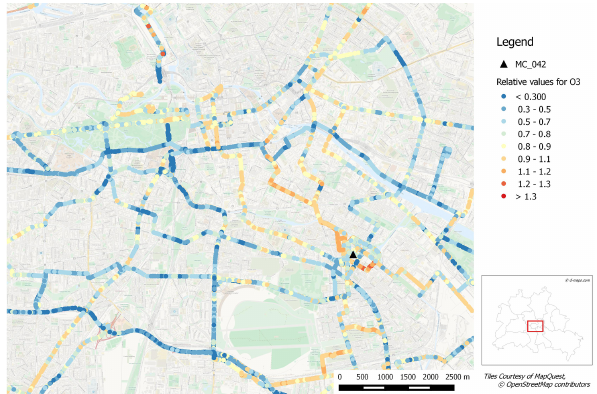
Figure 7. Horizontal variation of relative ozone mixing ratios, i.e., measured values relative to the ones at the same time in Neukölln. As before, white indicates less than 10% difference to the reference